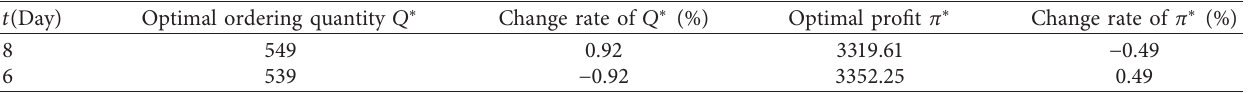
Table 3: Influence of lead time change on the optimal ordering quantity and profit without